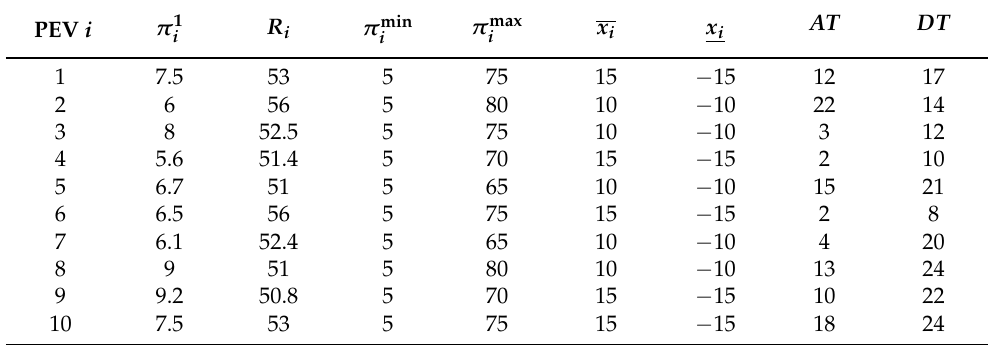
Table 1. Constraint-related parameters.